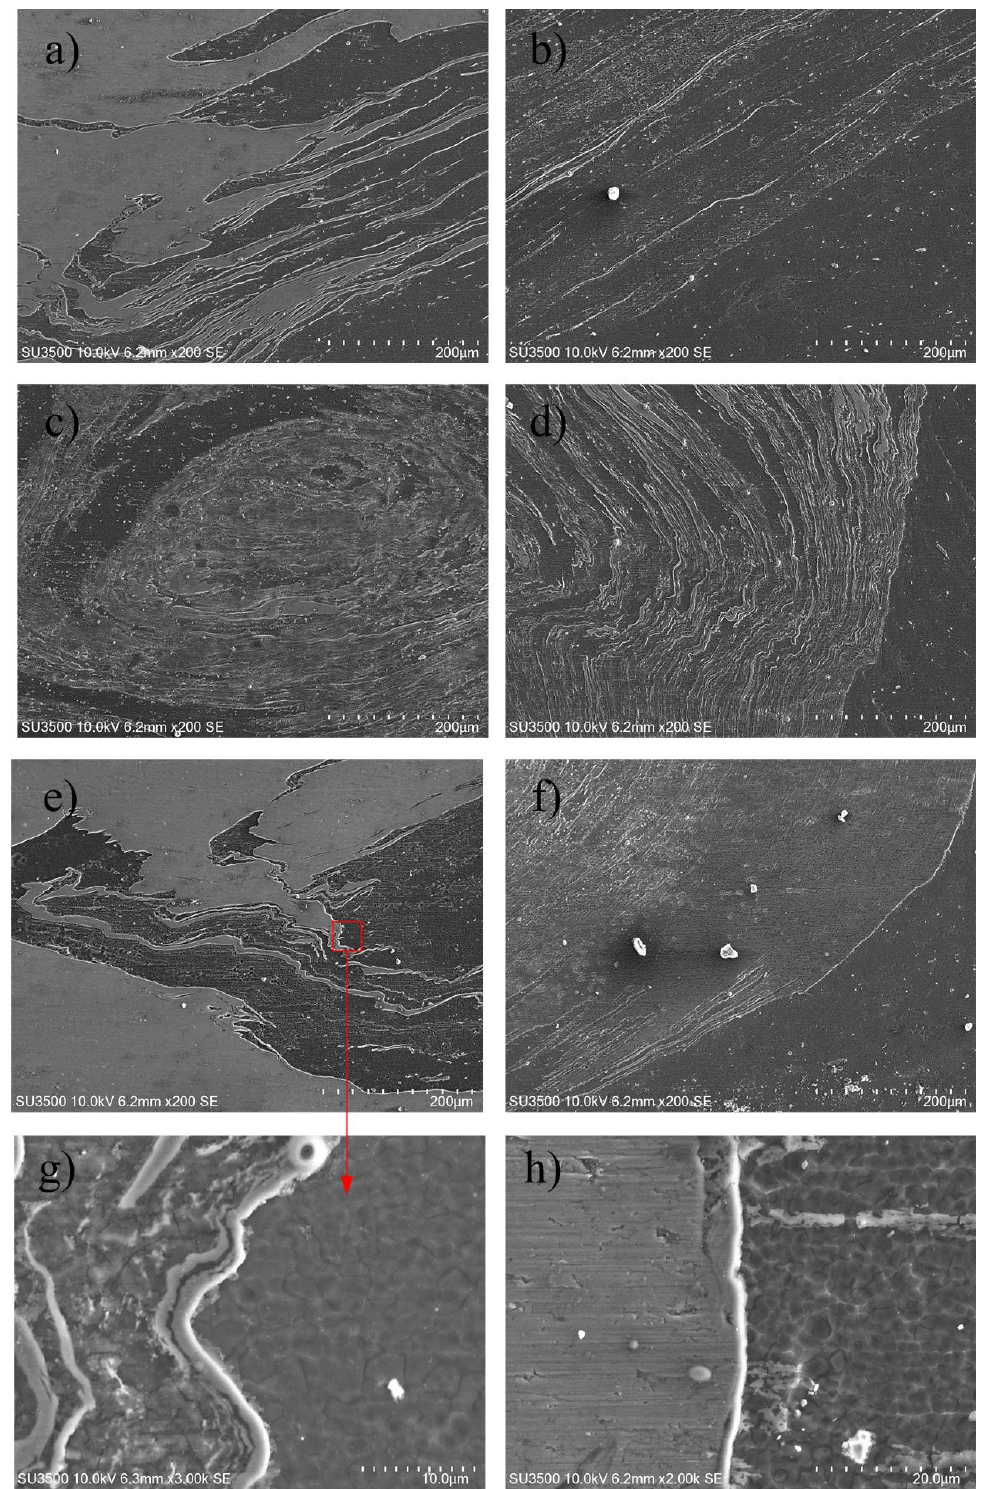
Figure 6: Microstructures at different locations marked in Figure 5d of joint at the welding speed of 60 mm/min and rotational speed of 1000